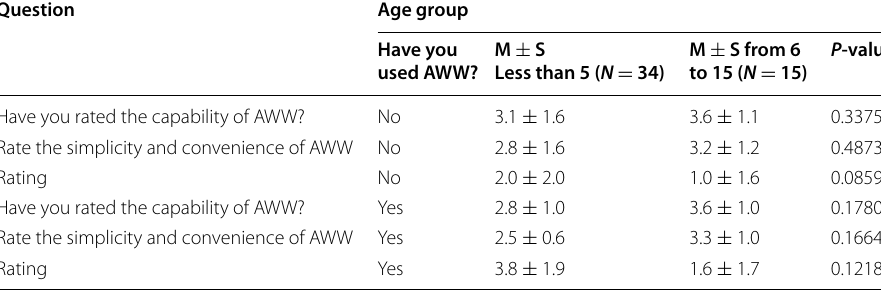
Table 12 Comparison of binary questions by number of written assignments for a semester Question